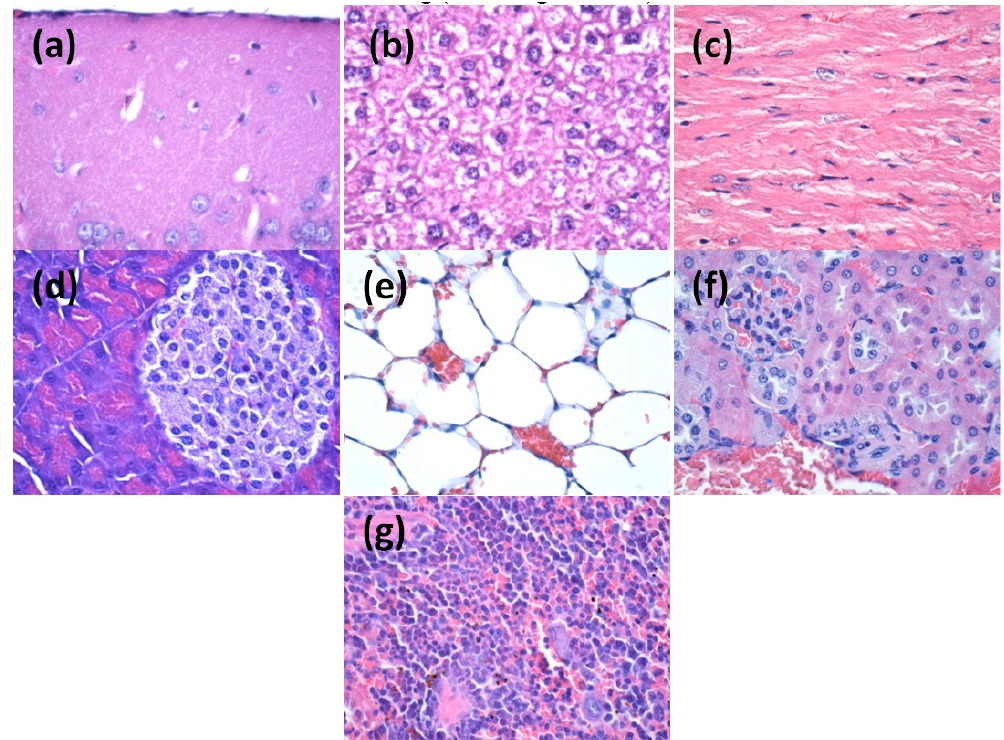
Figure 11. Transversal section through: ( a ) brain; ( b ) liver; ( c ) myocardium; ( d ) pancreas; ( e ) lungs; ( f ) kidneys; and ( g ) spleen from mice injected with AgNPs; samples collected at 10 days after the treatment; Hematoxylin-Eosin coloring (400× magnification).